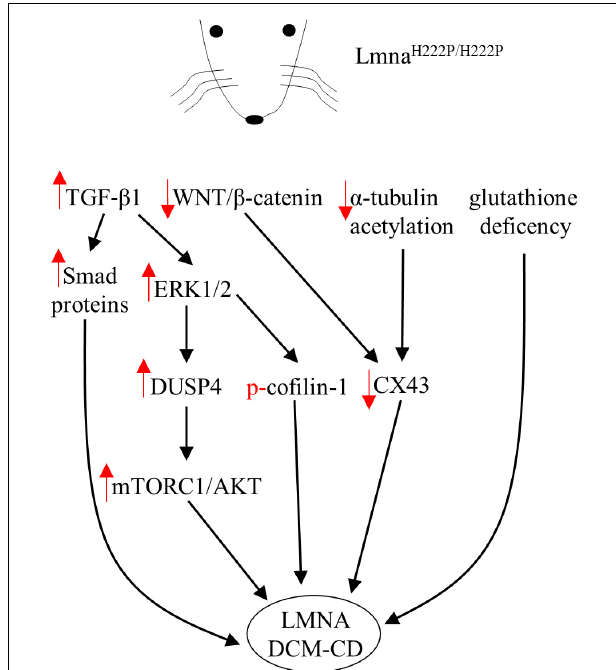
FIGURE 1 | Diagram showing signaling mediators and cellular targets affected in hearts of Lmna H222P / H222P mice. Red arrows indicate the effects (increase/decrease) induced by the mutation in terms of expression level or